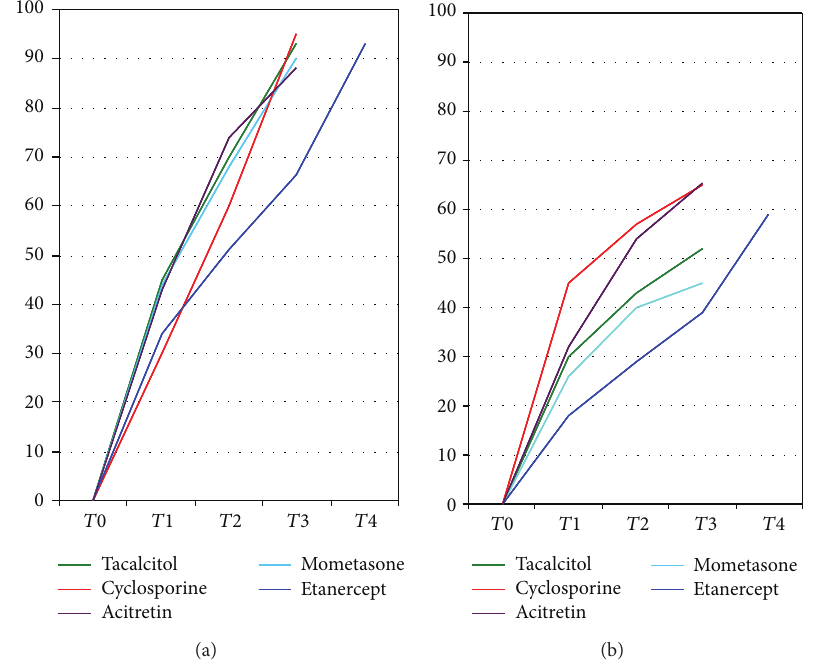
Figure 3: Mean improvement in clinical score (a) and mean reduction in basket diameter (b) at the psoriatic plaque treated with tacalcitol, mometasone furoate, cyclosporine A, etanercept [4–7], and acitretin at each time point as a percentage of baseline values. T0: start of treatment; T1: after 4 weeks; T2: after 8 weeks; T3: after 12 weeks; T4 (only for etanercept [5]): after 24